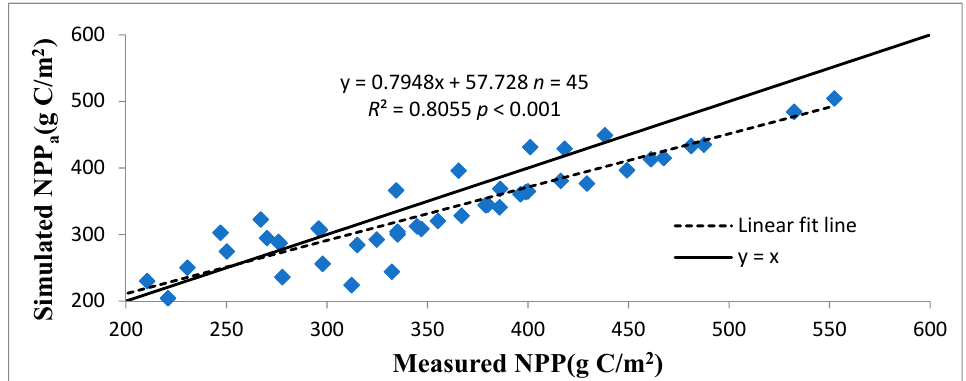
Figure 2. Comparison between the CASA model simulated NPP and the measured NPP in the Jinghe